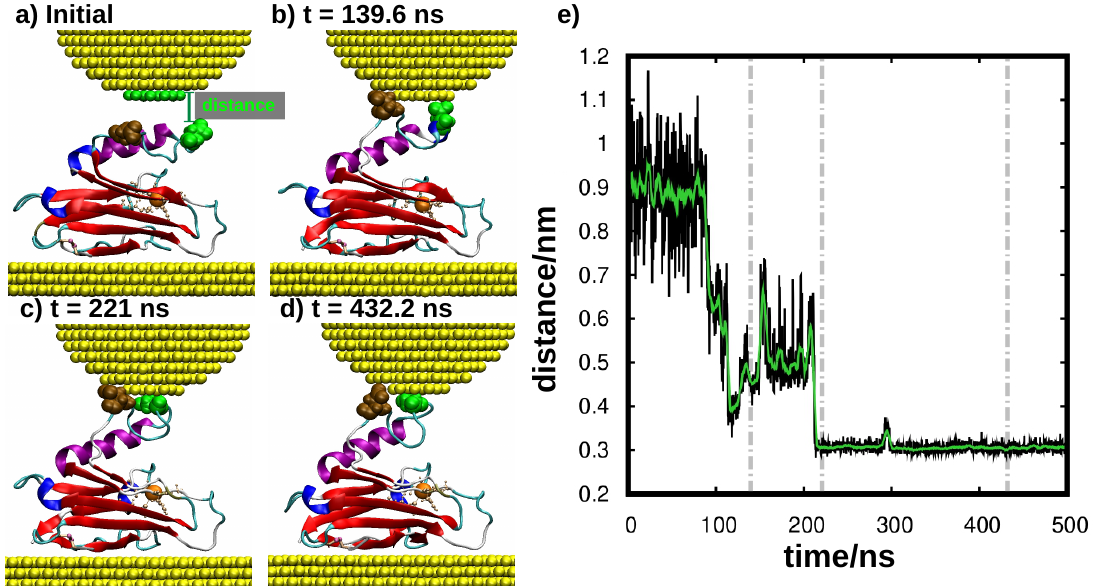
Figure 3. Dynamics of blinking tip-protein-surface contacts. ( a – d ) molecular dynamics (MD) simulation snapshots at representative tip-protein distances. The selected frames are highlighted via a gray dashed lined in panel ( e ). The surface/tip Au atoms are represented as yellow spheres, and the protein is represented using its secondary structure ( β -sheets in red, α -helix in purple, turns in cyan and random coils in gray). Note that the water molecules were not represented for clarity purposes. The two main anchoring amino acids in the protein-tip contact, i.e., the aspartic acids 76 and 69, are marked in brown and green color, respectively. ( e ) Time evolution of the distance between the tip and the topmost azurin atom (residue 69) in the MD simulations. The distance is defined as the difference between the z coordinate of the bottommost tip layer geometric center and the geometric center of the residue 69. In black, we represent the raw data, and in green, its running average over 6 ns time